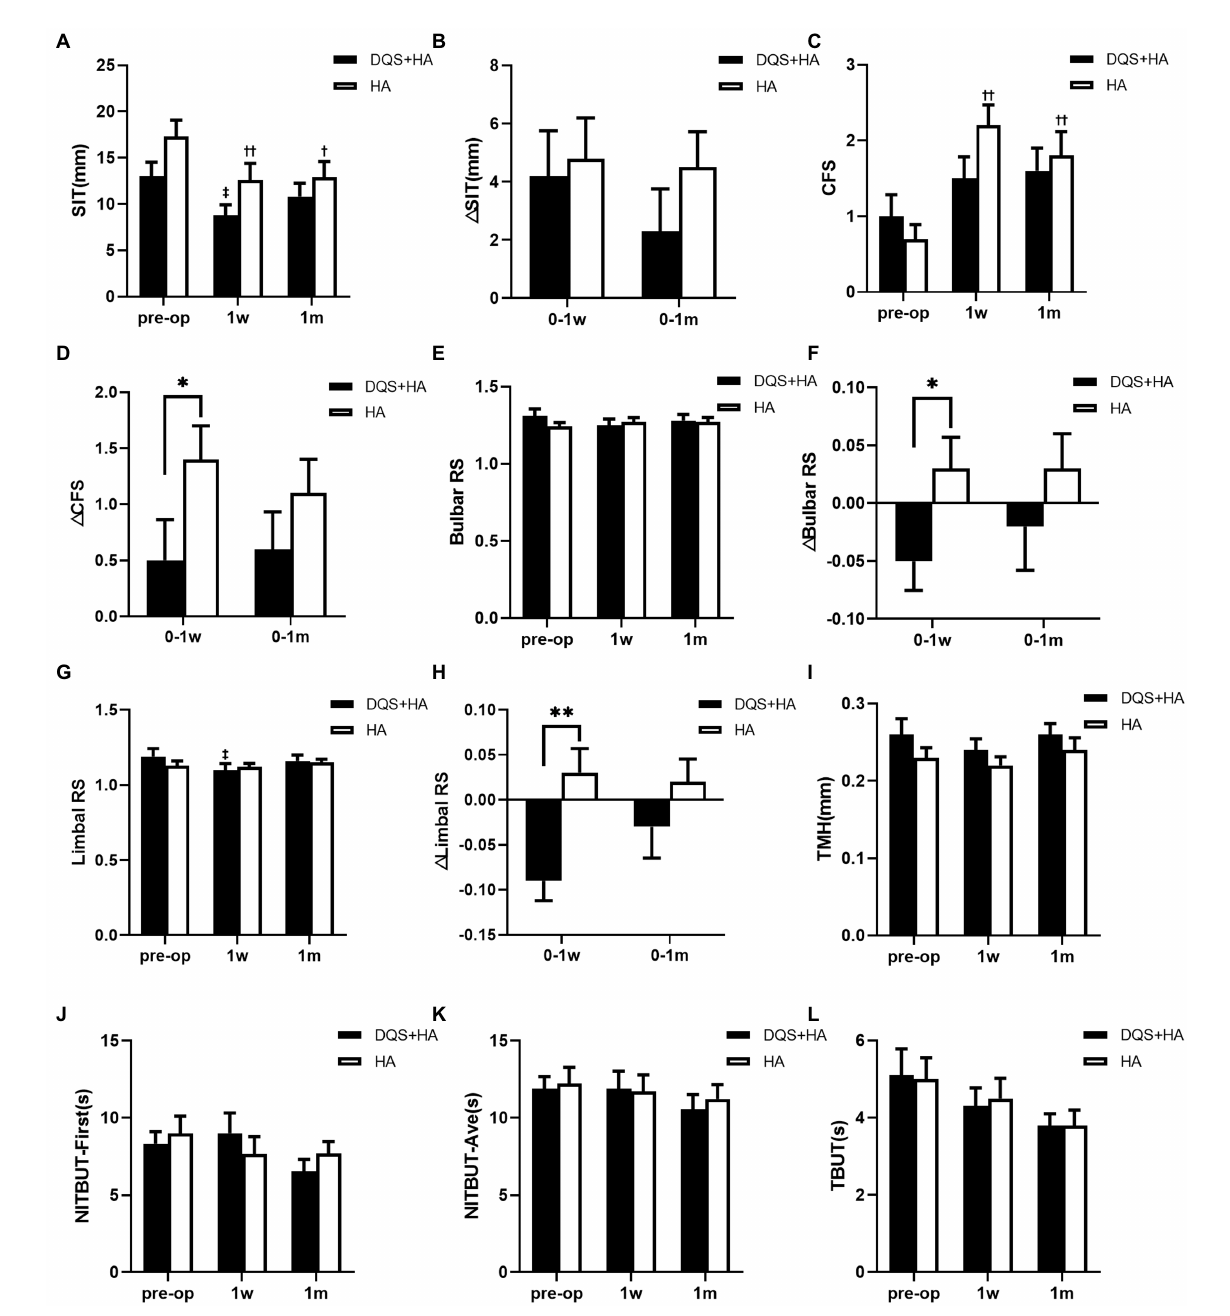
FIGURE 2 Changes in SIT (A,B) , CFS (C,D) , bulbar RS (E,F) , limbal RS (G,H) , TMH (I) , NIBUT-First (J) , NIBUT-Ave (K) , and TBUT (L) in patients after FS-LASIK. Mean value ± standard error. * p < 0.05 and ** p < 0.01 between the combination group and the HA group by independent samples t -test or Mann–Whitney U test. ‡ p < 0.05 between preoperative visit and postoperative visits in the combination group and † p < 0.05, †† p < 0.01 between preoperative visit and postoperative visits in the HA group by one-way repeated measures ANOVA or Friedman test. SIT, Schirmer I test; CFS, corneal fluorescein staining score; bulbar RS, bulbar redness score; limbal RS, limbal redness score; TMH, tear meniscus height; NIBUT-First, first non-invasive tear breakup time; NIBUT-Ave, average non-invasive tear breakup time; TBUT, tear breakup time; DQS + HA, combination of diquafosol tetrasodium and sodium hyaluronate; HA, sodium